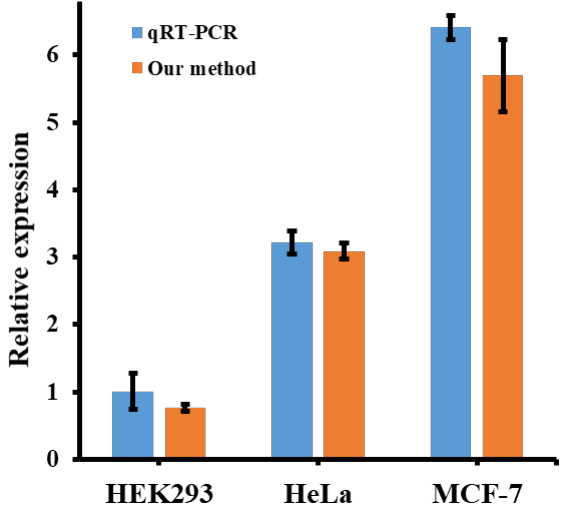
Figure 5. Histogram of miRNA-21 expression levels detected in MCF-7, HeLa, and HEK293 cells. Concentrations of cDNA, KF polymerase, NtBstNBI and TdT were 40 nM, 100 U/mL, 40 U/mL and 210 U/mL, respectively.